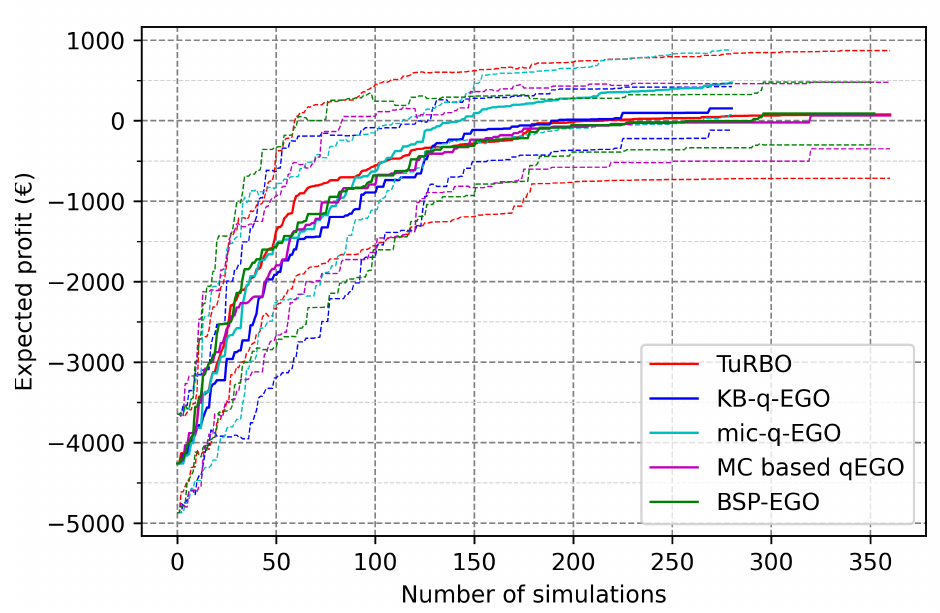
Figure 5. Evolution of the best-known objective value according to the number of executed cycles with n batch = 4. Solid lines indicate the average over 10 runs, and dashed lines of same colors indicate the standard deviation.